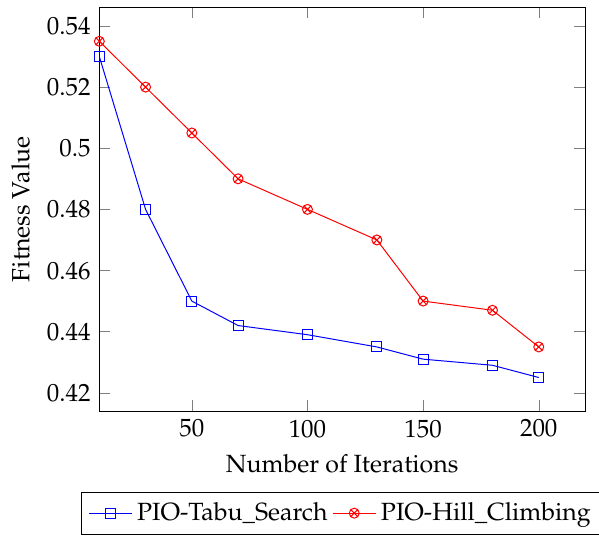
Figure 7. Hill climbing and Tabu convergence curve using UNSW-NB15 dataset.